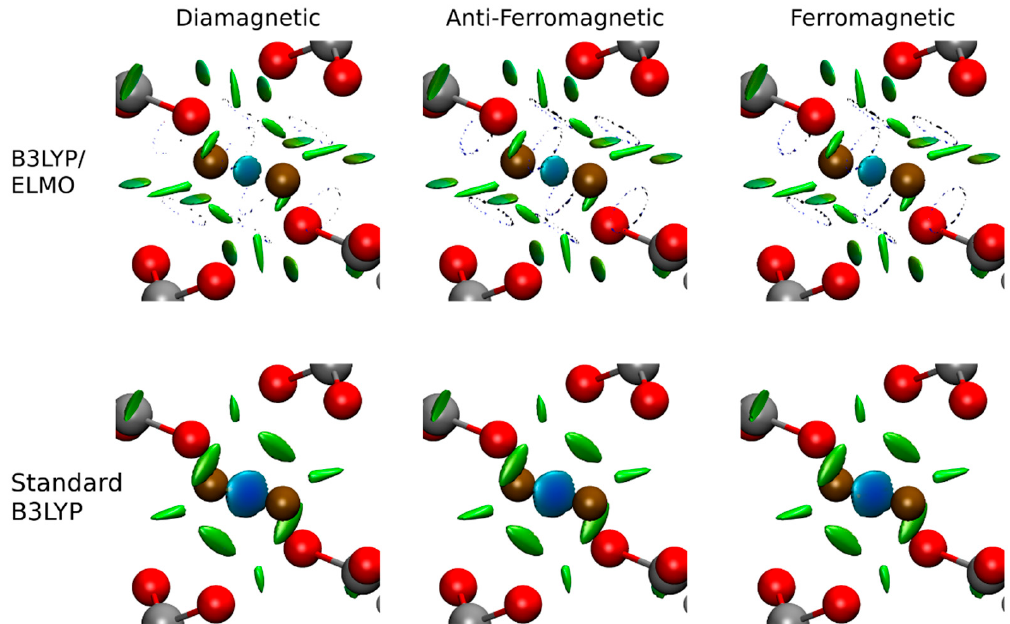
Figure 4. Zoom on the Cu-Cu subunit of the NCI plots depicted in Figure 3. All the reduced-density gradient isosurfaces correspond to the 0.4 a.u. isovalue and are colored according to the BGR (blue-green-red) scheme over the range − 5.0 a.u < sign ( λ ) ρ < 5.0 a.u.